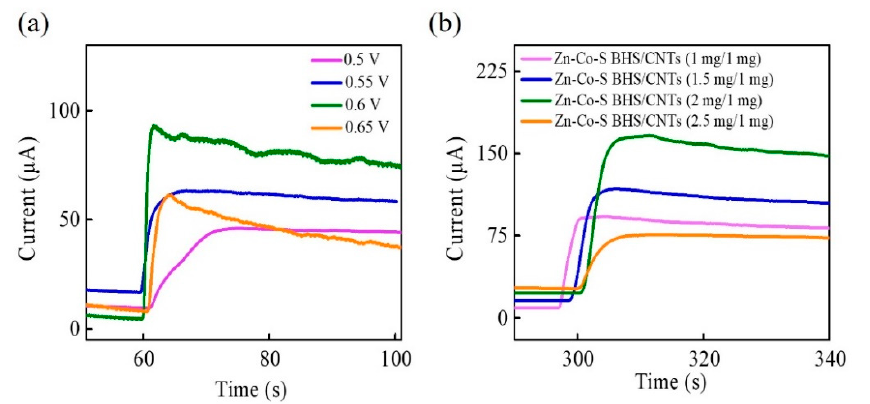
Figure 5. CA curves of Zn-Co-S BHS/CNTs with ( a ) different applied voltages and ( b ) CNTs (1 mg) and different the weight of Zn-Co-S BHS in 0.1 M NaOH in the 1.0 mM glucose.